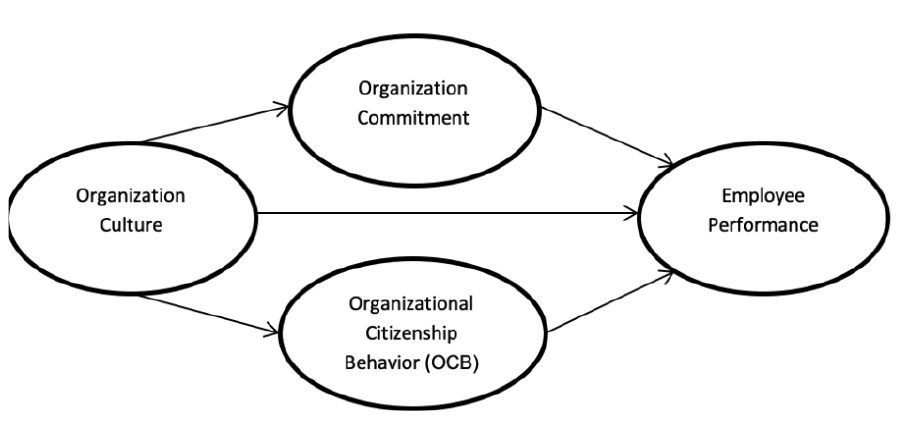
Figure 1: Research Framework and